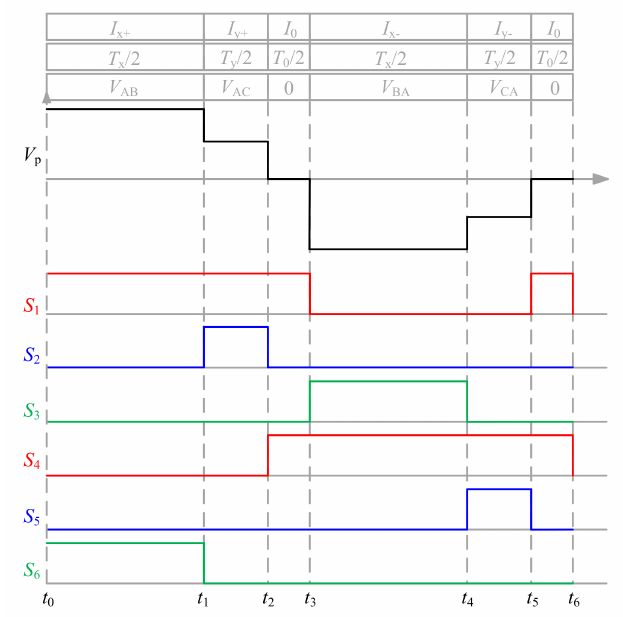
Figure 4. Waveforms of the transformer primary voltage and switching states.